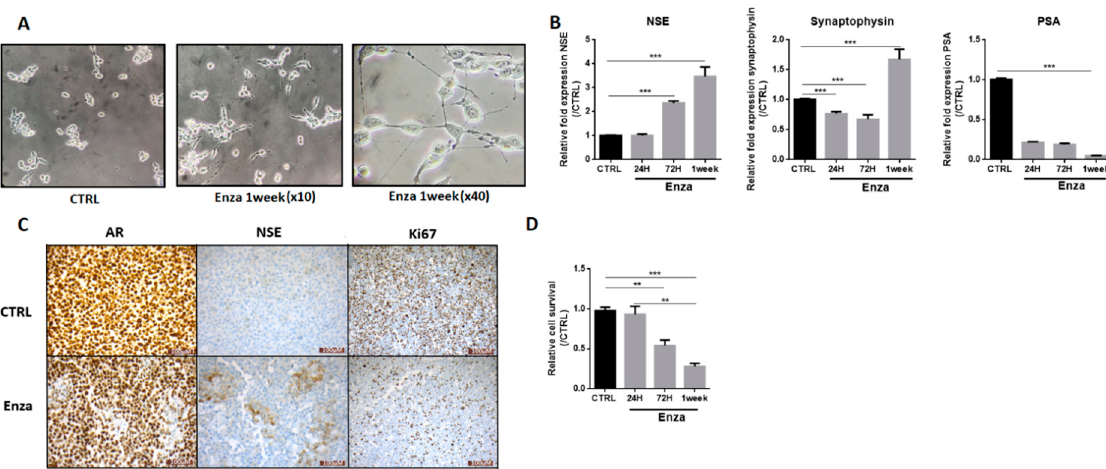
Figure 2. AR inhibition induces LNCaP neurodifferentiation. ( A ): Enza induces cytoplasmic extension in LNCaP cells. Pictures were obtained with an optical microscope (magnification × 10 or × 40); ( B ): Enza first increases neuronal marker expression, later NE markers, and inhibits PSA expression. LNCaP were treated with Enza (10 µ M) for 24 h, 72 h, and 1 week. qPCR results are normalized to the control condition and are expressed as mean ± S.E.M. The statistical differences are indicated: *** p < 0.001 (Kruskal–Wallis; post-test: Dunn) n = 3; ( C ): Enza treatment for 7 days decreases nuclear AR expression in cell foci expressing NSE and drastically decreases LNCaP proliferation. AR, NSE and Ki67 protein staining were obtained by immunohistochemistry; ( D ): Enza decreases cell proliferation. MTT assay was performed in LNCaP cells treated (or not) with Enza (10 µM) for 24 h, 72 h, and 1 week. Results are normalized to the control condition and are expressed as mean ± S.E.M. The statistical differences are indicated: ** p < 0.01; *** p < 0.001 (Kruskal–Wallis; post-test: Dunn) n = 3.